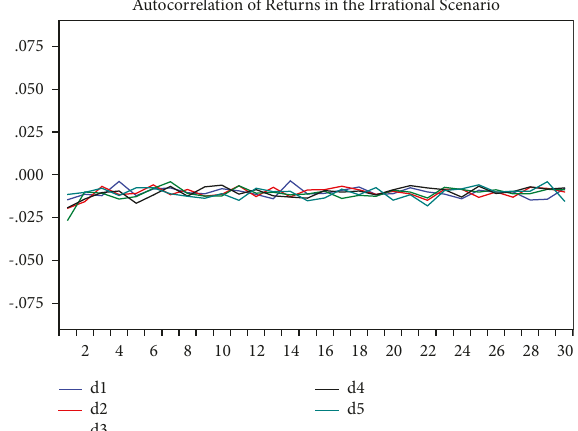
Figure 4: Autocorrelation of returns in the irrational scenario. In this figure, we plot the autocorrelation of returns when considering irrationality. The parameters of price determination and the fundamental price used in the simulations are calibrated. The behavioral hesitation and decision rigidity of the anxious agent are represented by d , which extends from 1 to 5. The lengths of the lags range from 1 to